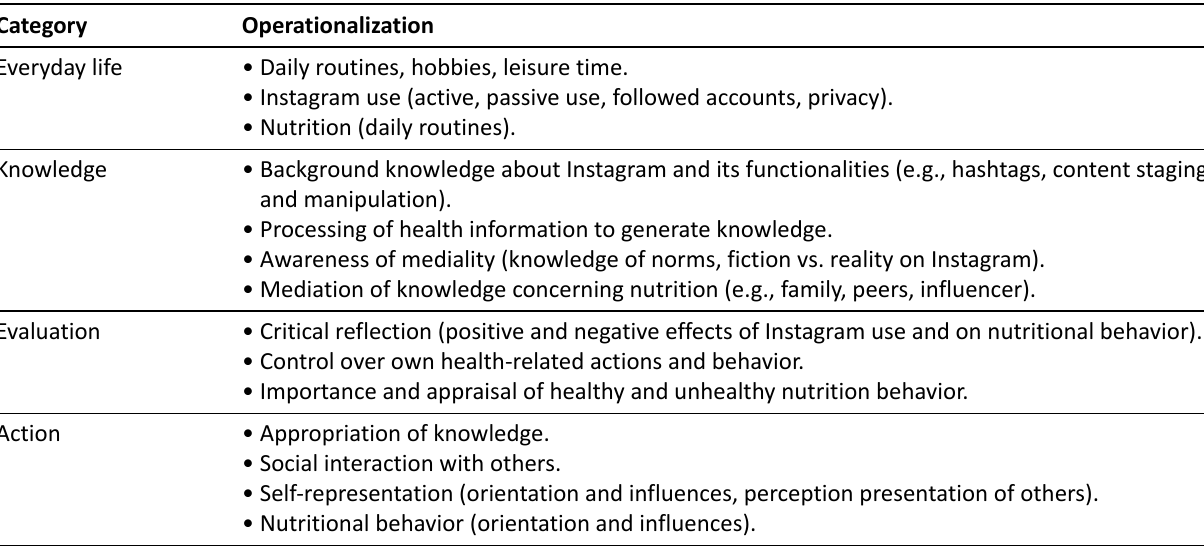
Table 2. Category